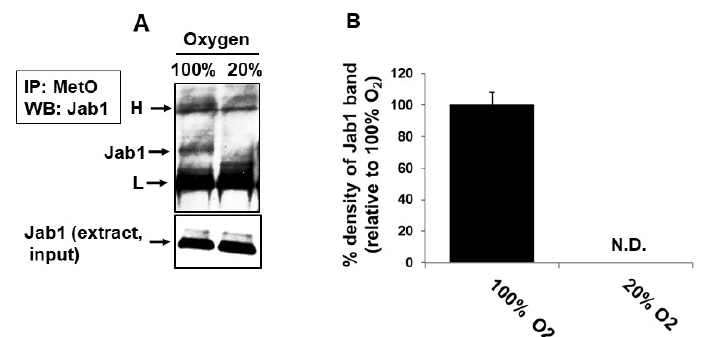
Figure 3. Met oxidation of Jab1 in mice exposed to hyperoxia (100% oxygen). WT mice (6 months old, n = 5) were exposed to hyperoxia for 24 h. Thereafter, the mice were euthanized and brain extracts were made in PBS as described under Section 2. ( A ) Immunoprecipitation with rabbit anti-MetO antibody were performed using 500 µ g of extracted protein from each brain, followed by Western blot analyses probed with the primary mouse anti-Jab1 antibody (see details under Section 2). ( B ) Quantification of the Jab1 band detected by Western blot analysis in Panel A, by using the NIH Image-J program. N.D, not detected; H, heavy chain of brain mouse IgG; L, light chain of brain mouse IgG. A representative blot is shown.